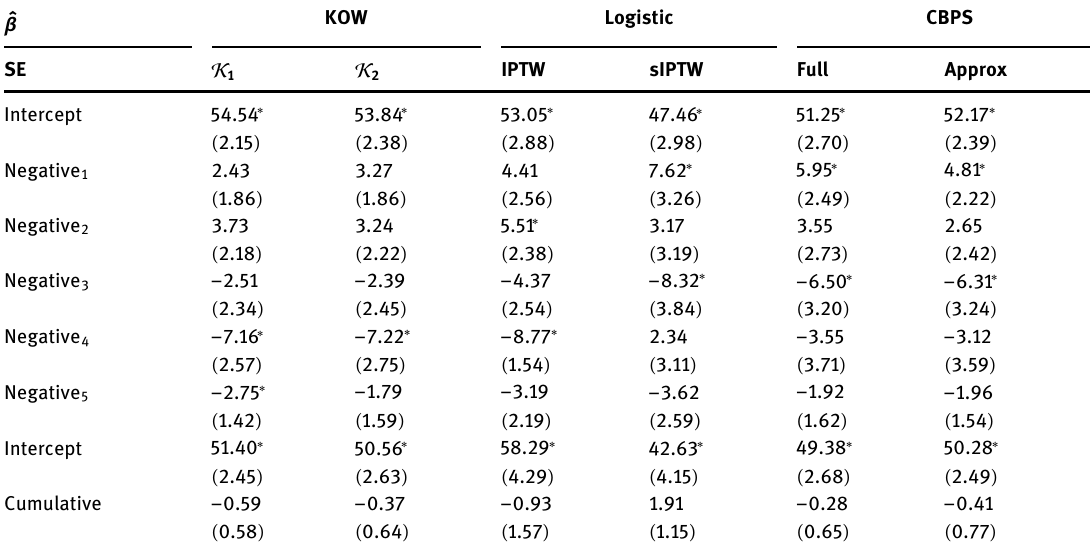
Table 2: Impact of negative advertising on election outcomes β